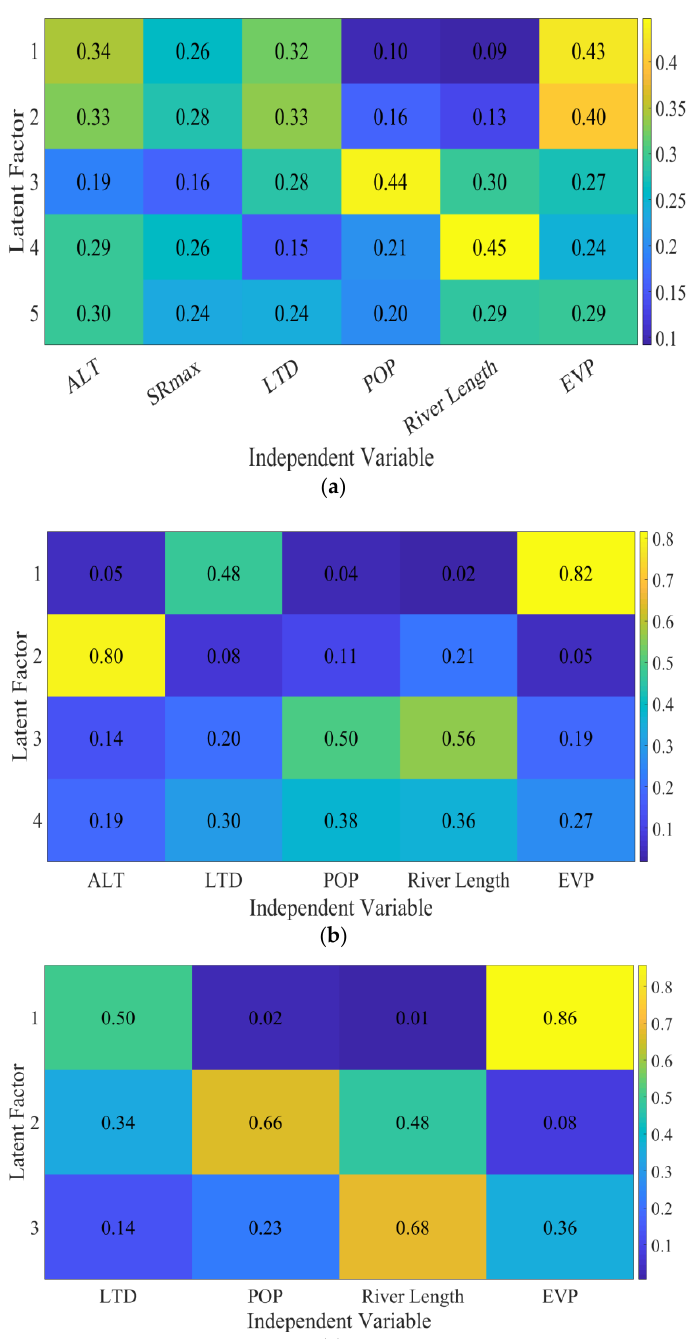
Figure 5. Non-negative matrix factorization (NMF) heat maps. ( a ) Heat map of six NMF factors. ( b ) Heat map of five NMF factors. ( c ) Heat map of four NMF factors.